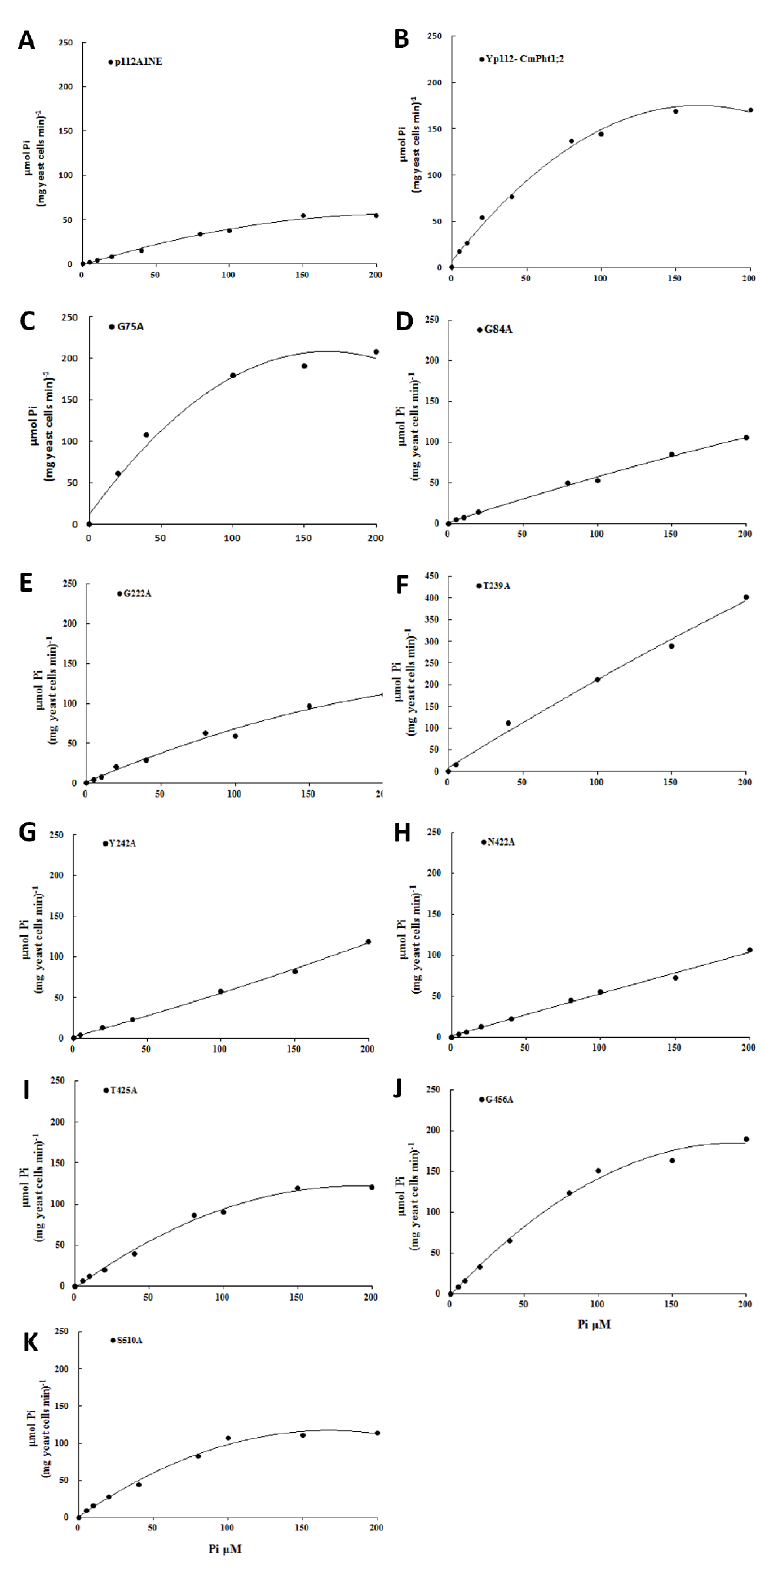
Figure 5. Velocity of 32 Pi uptake of MB192 with CmPT2 and Cmphts expression . ( A ): p112A1NE